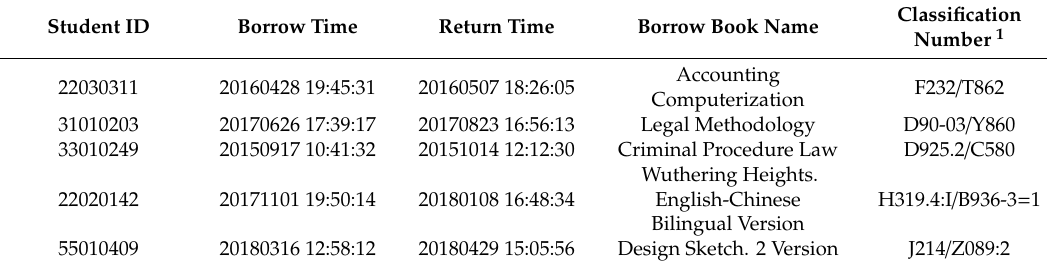
Table 3. Book lending information